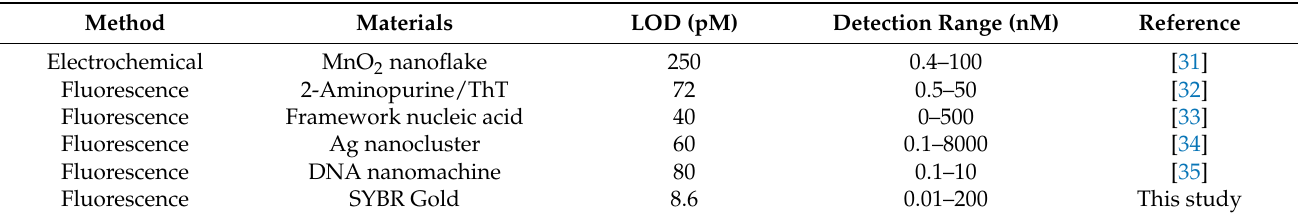
Table 2. Comparison of different detection methods.